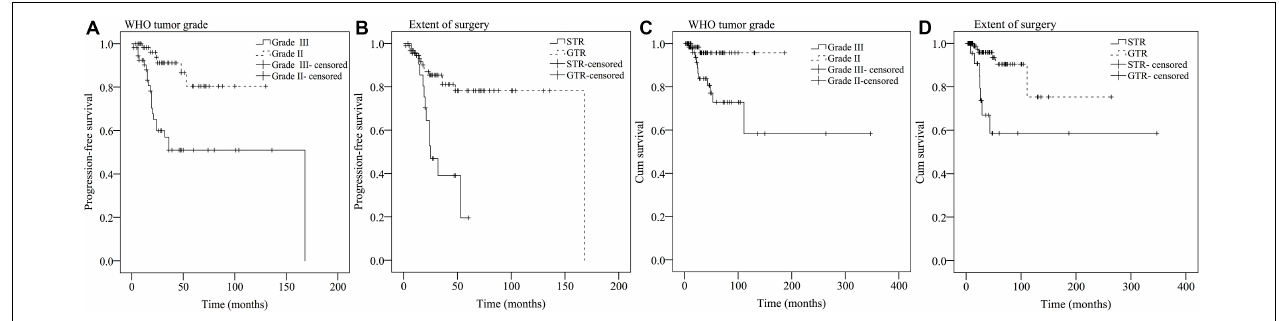
FIGURE 2 | Kaplan–Meier survival curves of prognostic factors significant in multivariate analysis for PFS (A,B) and OS (C,D) .